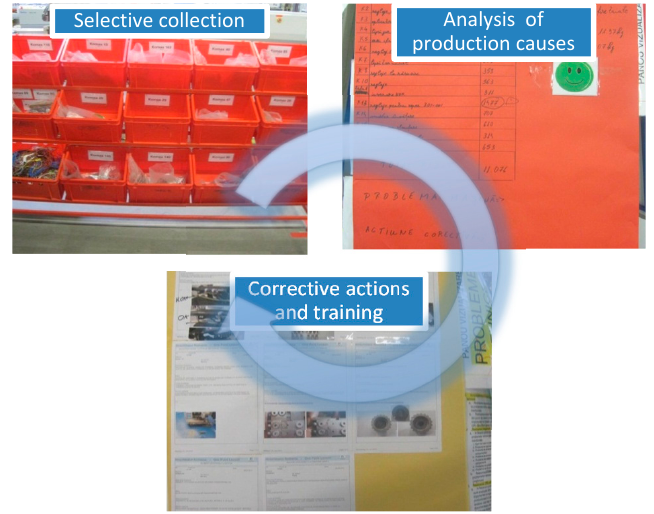
Figure 5. The flow of information in the daily analysis of defects.